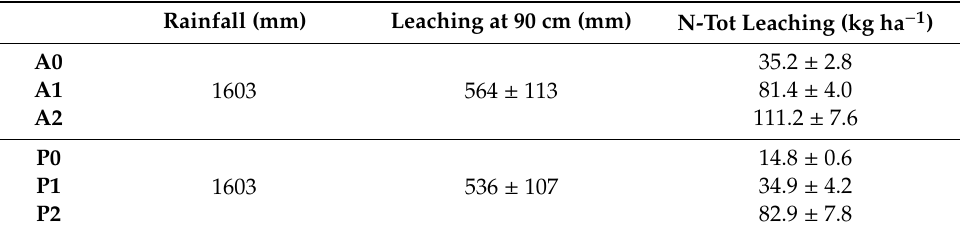
Table 3. Percolation rate at 90 cm depth and leaching of N for each